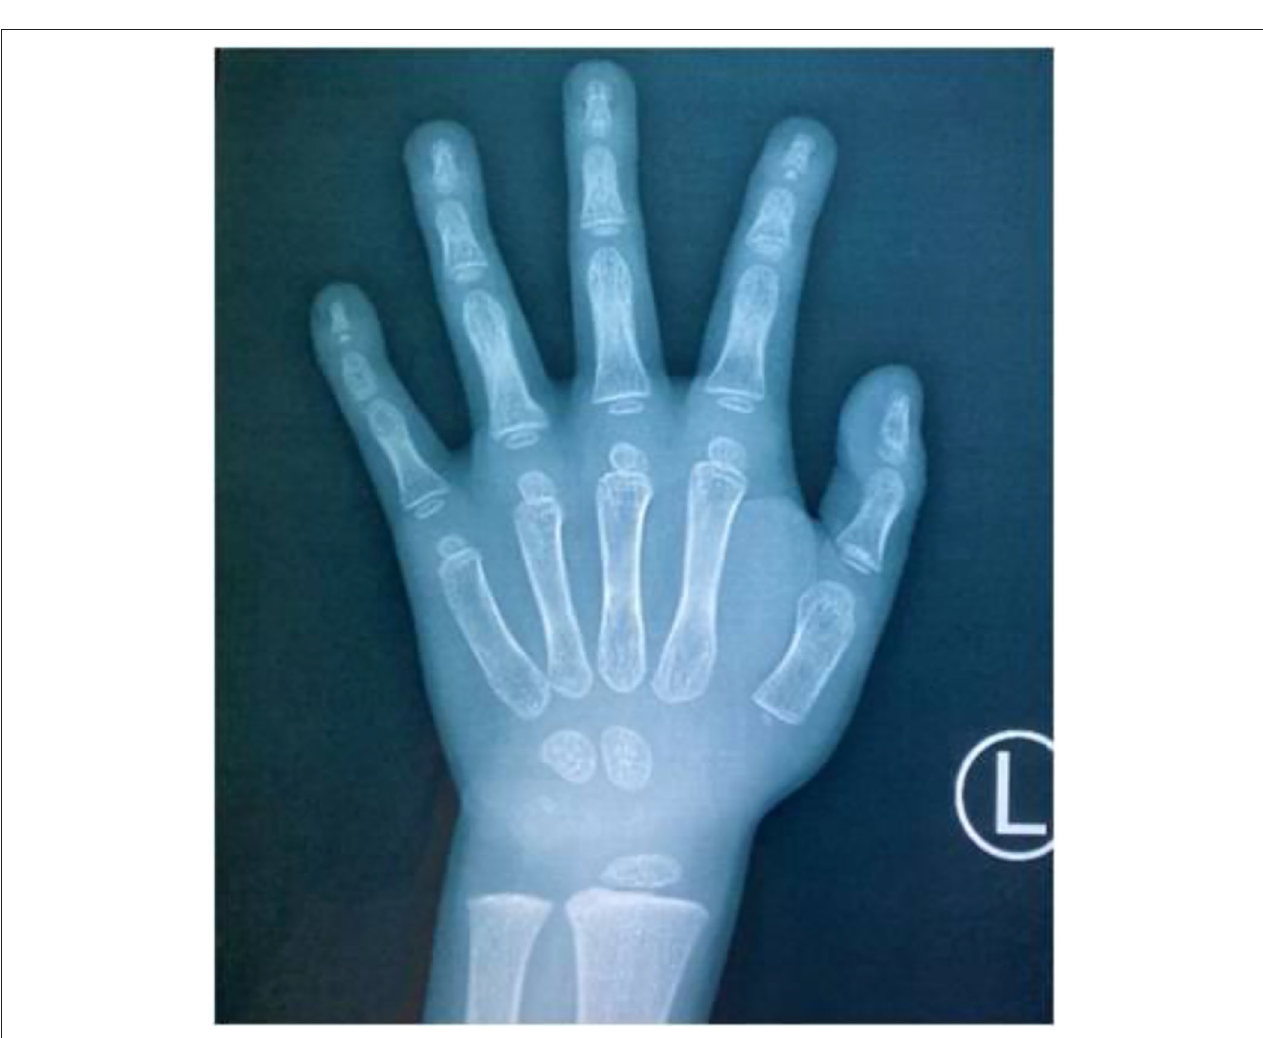
FIGURE 2 | Direct radiography of the child’s left hand. The bone age was 4 years (3 years behind the patient’s actual age), the finger bones were short and thin, the distal phalanges were prominent, the little finger was inwardly curved, and the middle phalanges of the little finger were irregularly shaped.